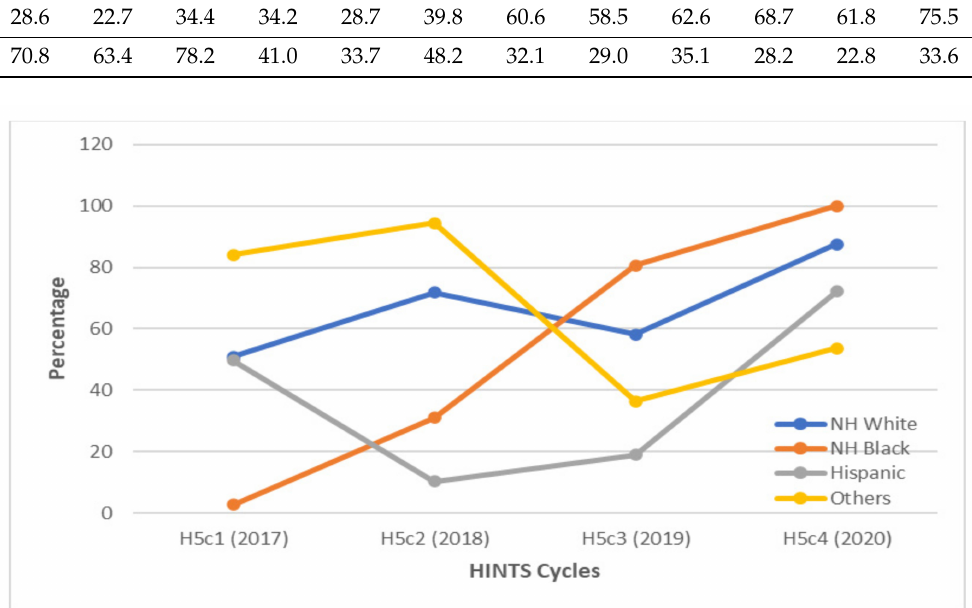
Figure 6. Awareness of the HPV vaccine among gay and bisexual males according to race/ethnicity between 2017 and 2020. There was a decrease in awareness about the HPV vaccine among Hispanic GBM between 2017 and 2018, followed by increased awareness during the rest of the study period. NH = non-Hispanic